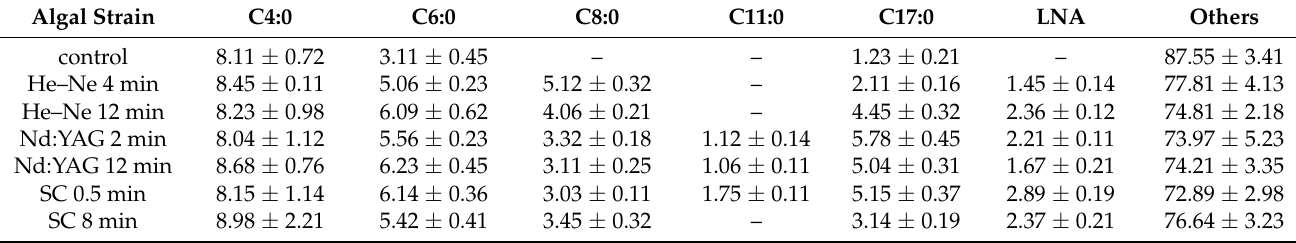
Table 3. Effect of laser mutagenesis and heterotrophic cultivation on lipid components Chlorella pyrenoidesa strain FACHB 31. C4:0, butyric acid; C6:0, caproic acid; C8:0, decanoic acid; C11:0, undecanoic acid; C17:0, heptadecanoic acid; LNA, linolenic